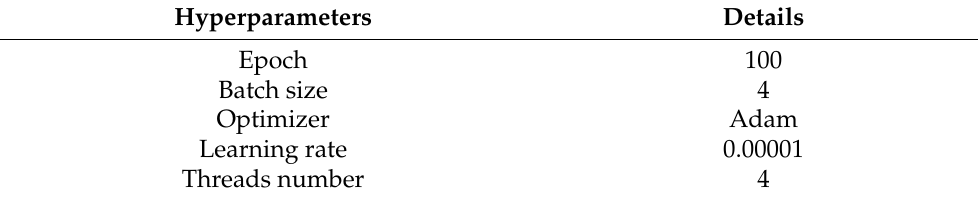
Table 1. Hyperparameter